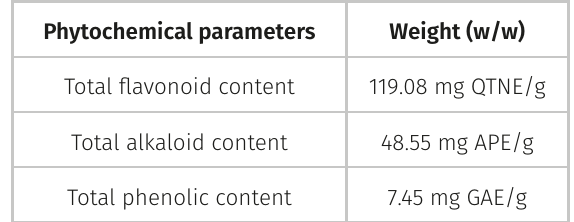
Table IV. Phytochemical analysis of the S. hispanica seeds extract.